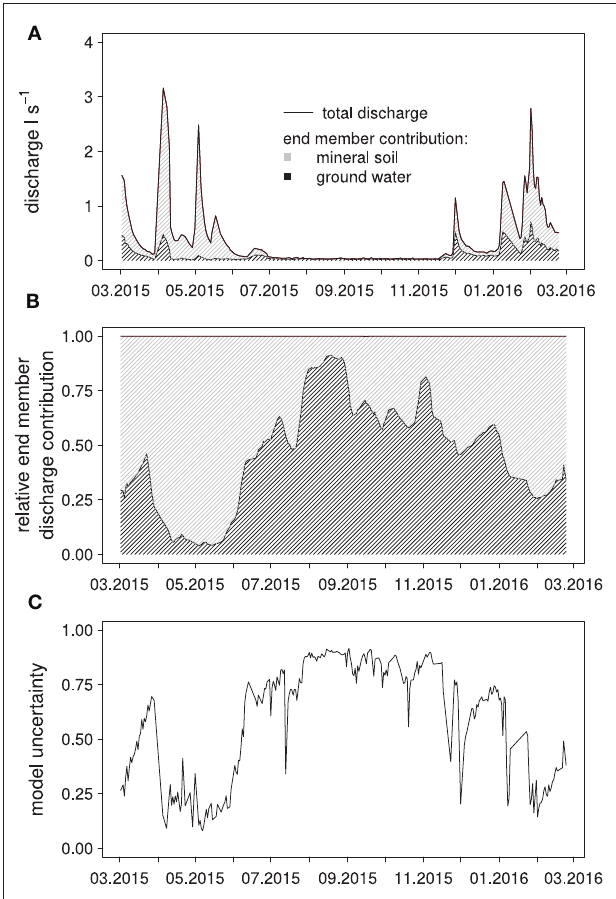
FIGURE 3 | Results of the EMMA: Calculated absolute contributions of the end members to spring discharge (A) ; water from the forest floor was used as an end member but ended up not contributing significant amounts to the simulated discharge composition, simulated, end member contributions to discharge (B) and relative model uncertainty (C)